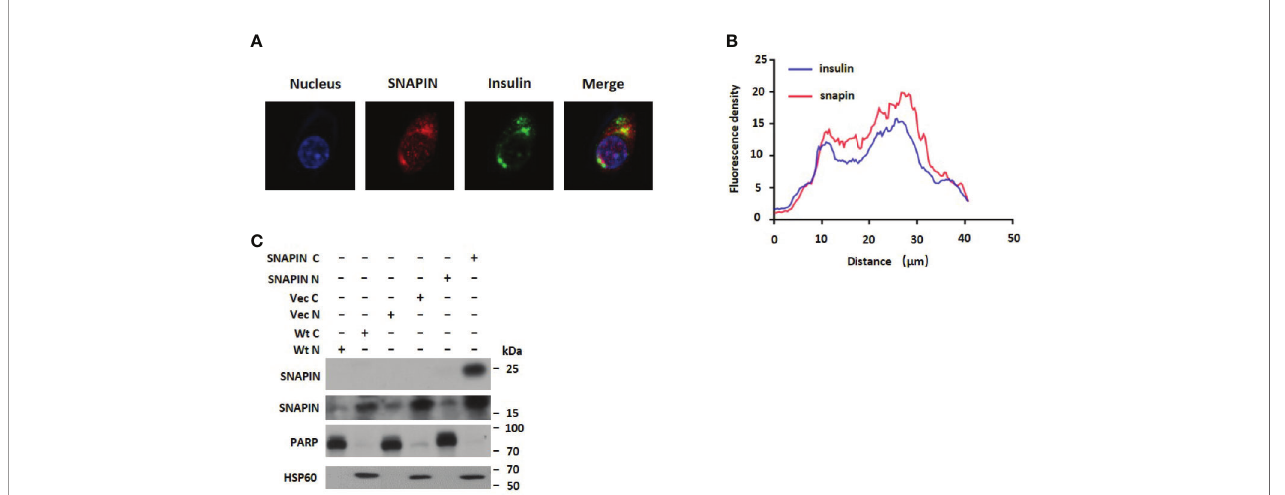
FIGURE 2 | Subcellular localization of SNAPIN. (A) . Immuno fl uorescence was performed to measure the subcellular localization of SNAPIN. SNAPIN was visualized in INS-1 and Min6 cells using anti- SNAPIN antibody in conjunction with anti-rabbit FITC, whereas insulin was visualized using anti-insulin and red-conjugated goat anti- mouse. Slides were mounted and fl uorescence viewed under a laser scanning confocal microscope equipped with a 488 nm laser excitation fi lter for FITC. The nuclei were labeled with DAPI (blue) (4 ʹ ,6-diamidino-2-phenylindole), and SNAPIN protein was labeled with the Alesa Fluor 643 (red). Scale bar, 2 mm. (B) The fl uorescence distribution of SNAPIN and insulin was analyzed by ImageJ. (C) Nucleocytoplasmic separation was performed to measure the Subcellular localization of SNAPIN. PARP is the nuclear marker, and HSP60 is the cytoplasmic marker. SNAPIN is mainly located in the